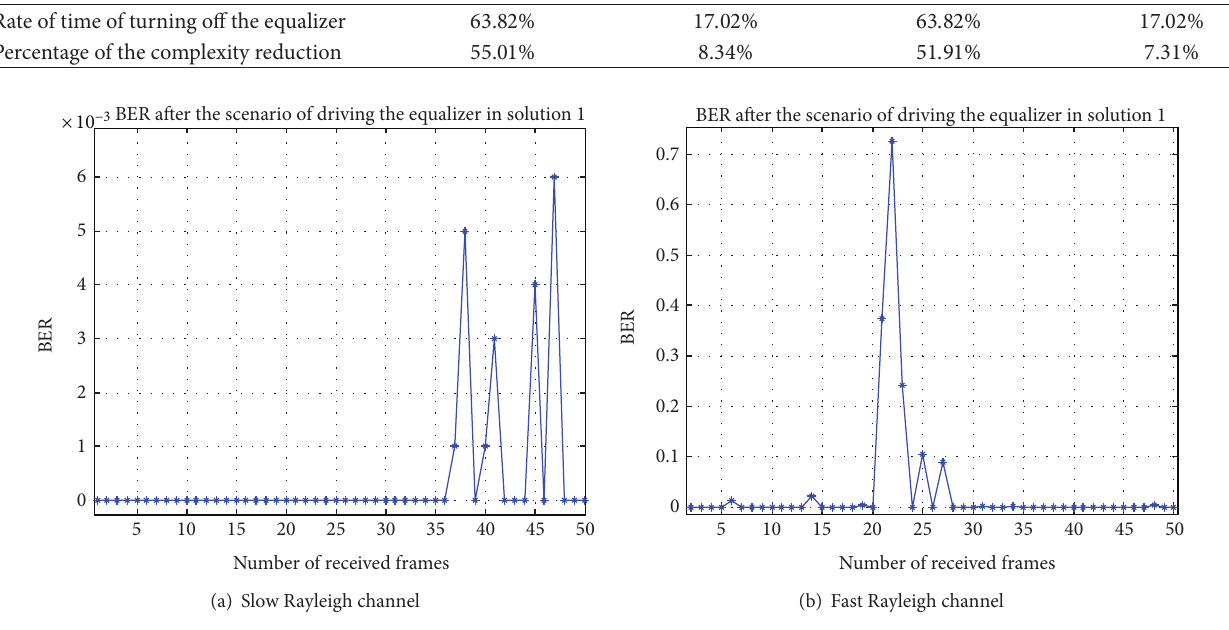
F 13: Performance of the system aer decision making for the rayleigh channel with solution 1: errors of the equalizer due to its interruptions and reinitializations.